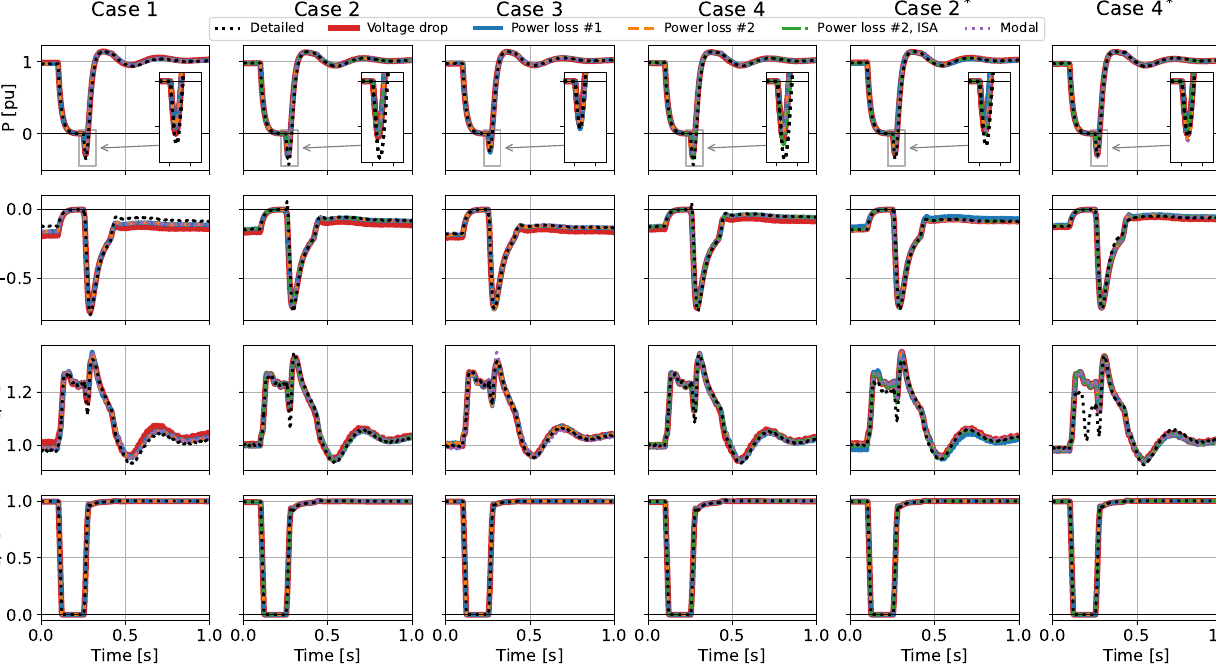
Figure A1. Time-domain simulation results from PSCAD for all case